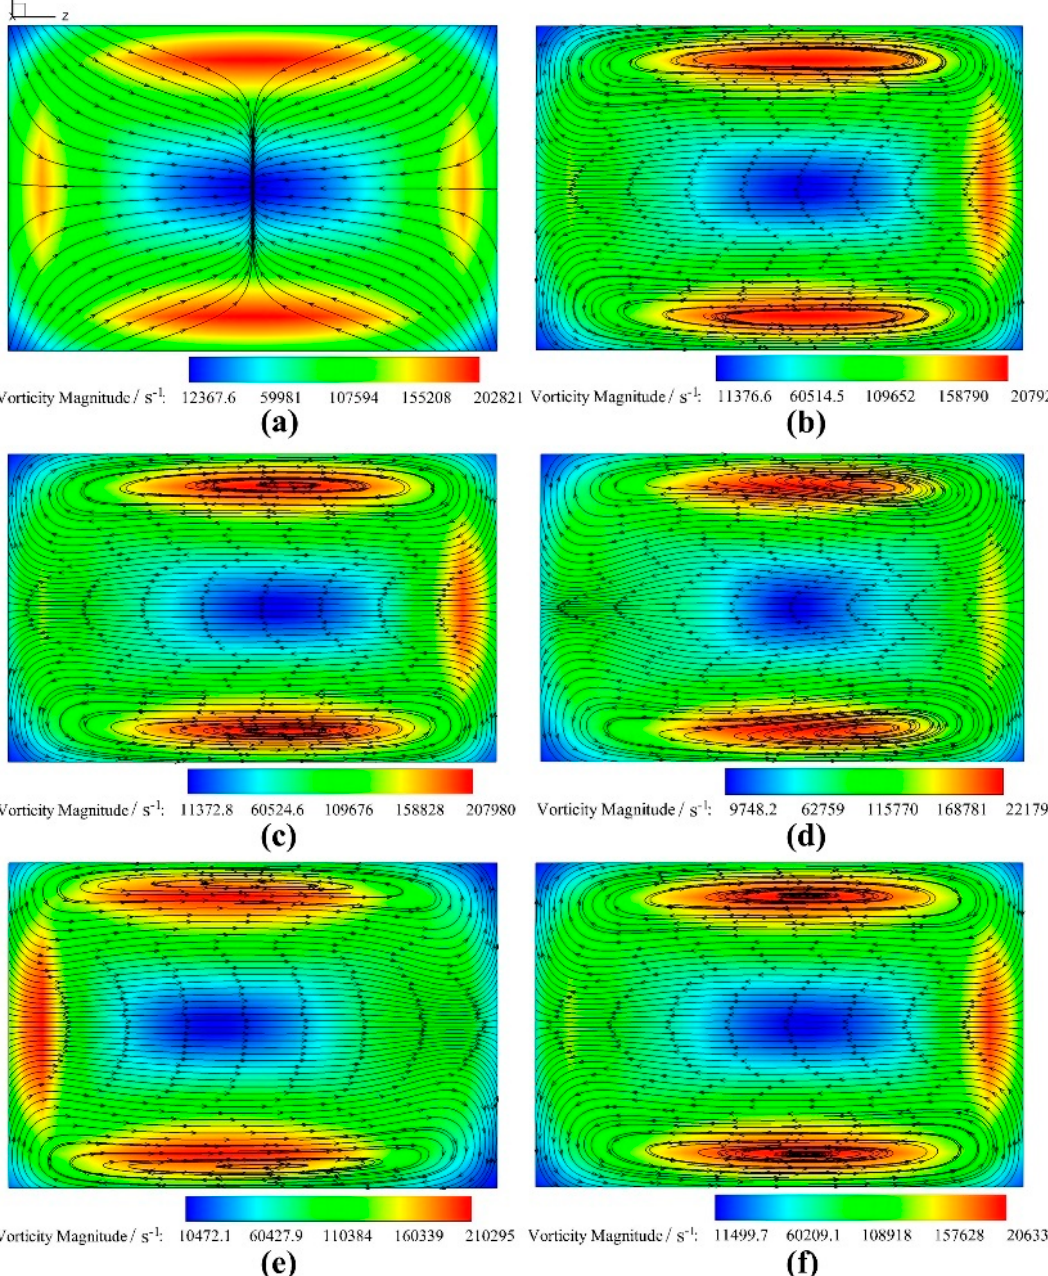
Figure 4. Velocity streamlines superimposed with vorticity magnitude contours along the Y–Z cross-section of the channels under investigation with x = 12.5 mm: ( a ) straight; ( b ) Design 1; ( c ) Design 2; ( d ) Design 3; ( e ) Design 4; ( f ) Design 5.